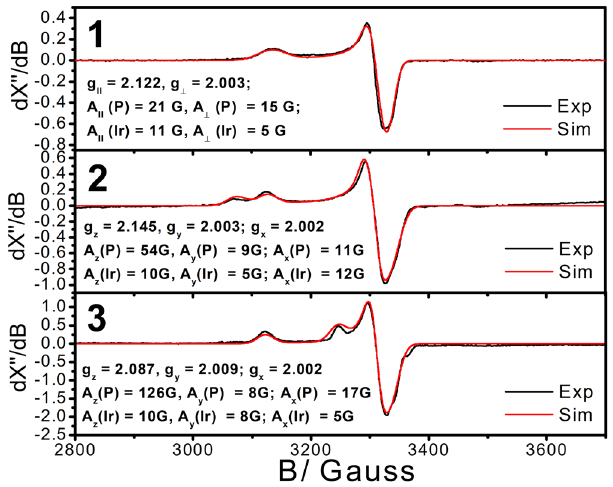
Fig. 9 X-Band EPR spectra of 1 – 3. The spectra were recorded for the samples in CH 3 CN at 100 K after white light photoirradiation for 5 min at 298 K (black) and the simulated spectra (red). Frequency: 9.299527 GHz; modulation amplitude: 8.0 G; power: 2.0